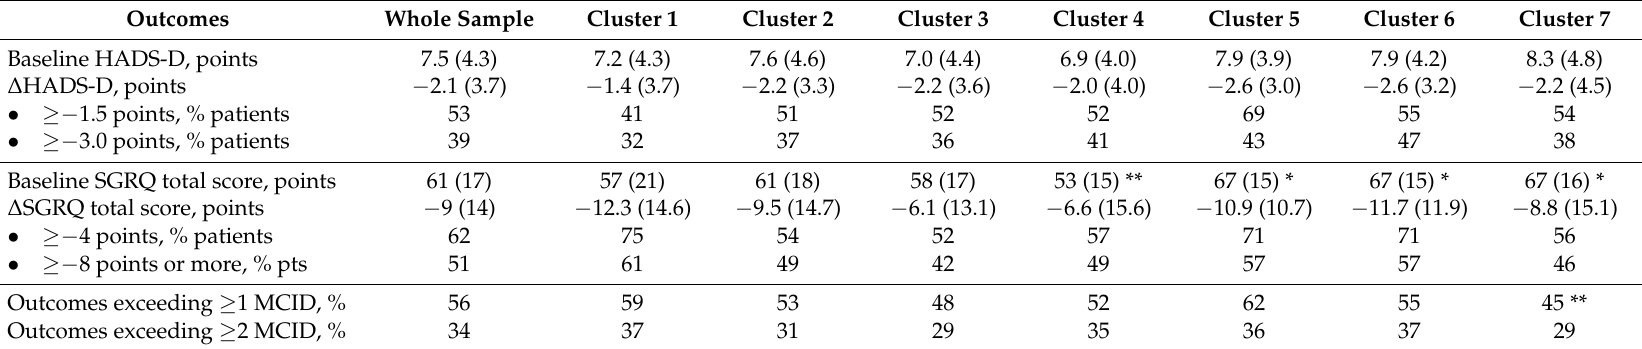
Legend of Table 1: The efficacy of pulmonary rehabilitation based on minimal clinically important difference (MCID). Data is presented as mean (SD), unless otherwise stated. ∆ : change; mMRC: modified Medical Research Council; 6 MWD: 6-min walk distance; CWRT: constant work-rate test; COPM-P: Canadian Occupational Performance Measure, performance score; COPM-S: Canadian Occupational Performance Measure, satisfaction score; HADS-A: Hospital Anxiety and Depression Scale, anxiety scores; HADS-D: Hospital Anxiety and Depression Scale, depression scores and SGRQ-T: St. George’s Respiratory Questionnaire, total score. * = a significantly higher difference compared to the whole sample ( p < 0.01). ** = a significantly lower difference compared to the whole sample ( p <